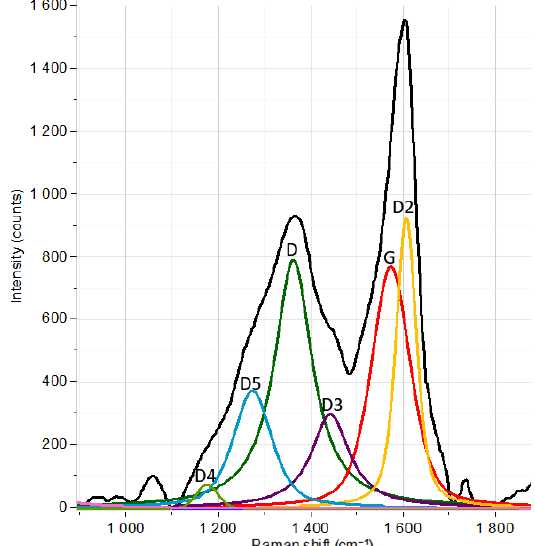
Figure 3. Schematic of band picking of a Raman spectrum of a representative organic matter (OM) sample of this study. Table 3. Information on the sample band spectral shifts.